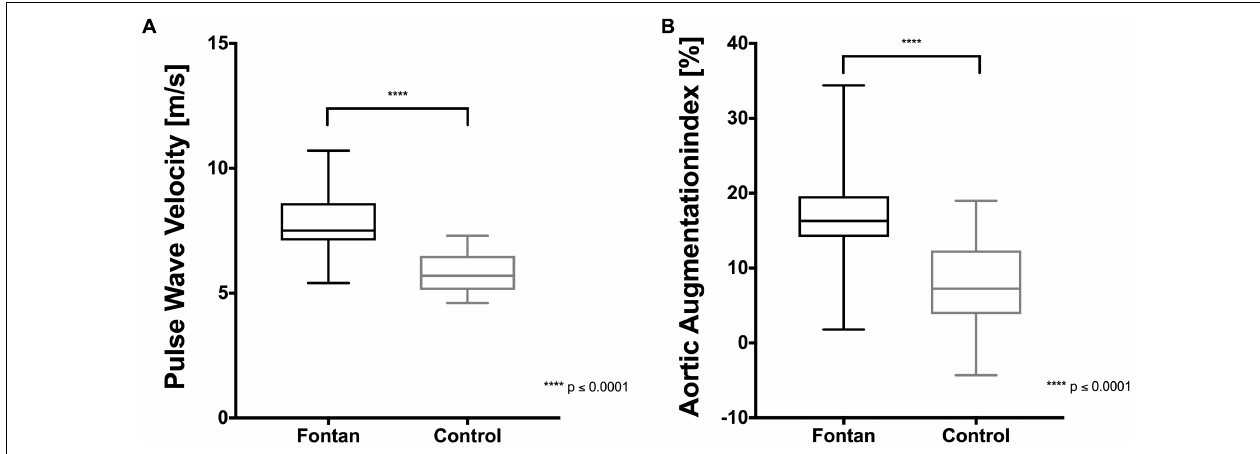
FIGURE 2 | Arterial stiffness in Fontan patients and healthy controls. (A) Pulse wave velocity (PWV) and (B) aortic augmentation index (AIx) were significantly higher in Fontan patients compared to healthy